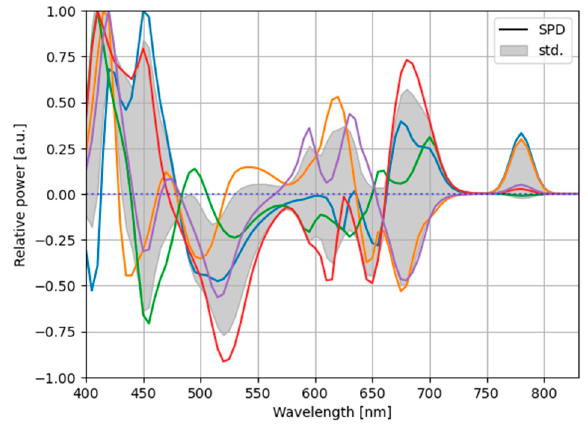
Figure 12. The performance of each method of the band-aligned SPD utilizing the NIR in the 400– 1000 nm band with the proposed method with CNN: ( a ) F1-score for each method, and ( b ) compar- ison of performance between the reference (D65) and the optimal light. In the three models utilizing the 400–1000 nm band, the lighting weights were initialized in different ways: randomized in [0,1], approximating D65, and as uniform vector 1, respectively.